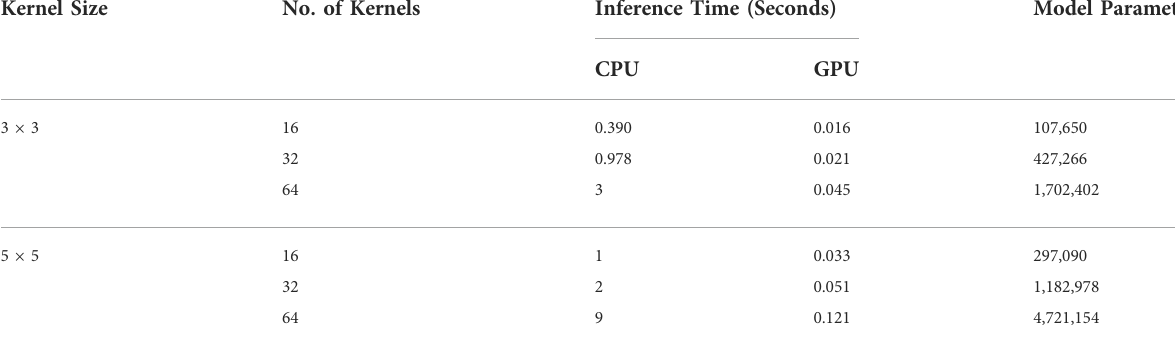
TABLE 6 Mean inference time and model parameters for various hyperparameter con fi gurations. Kernel